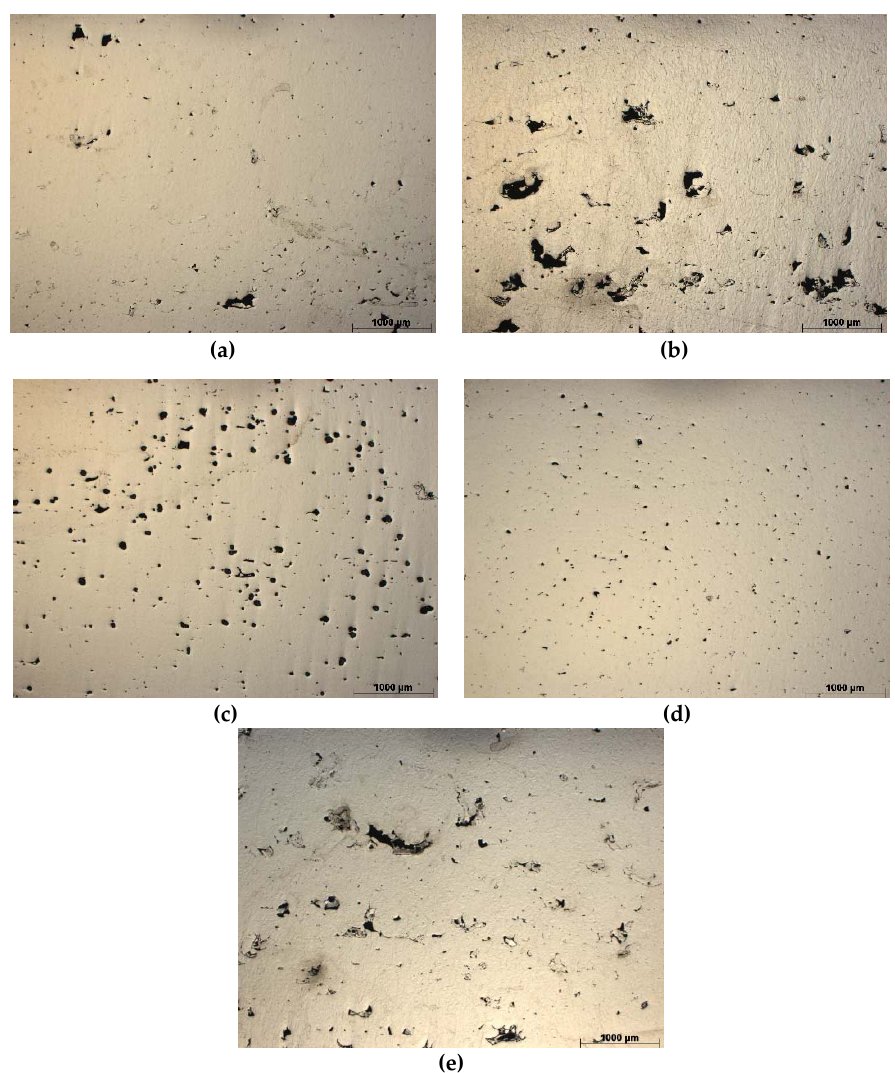
Figure 3. Light optical microscopy (LOM) images show defects in the horizontal cross-sections on analyzed material; ( a – e ) corresponds to sample numbers presented in Table 2.